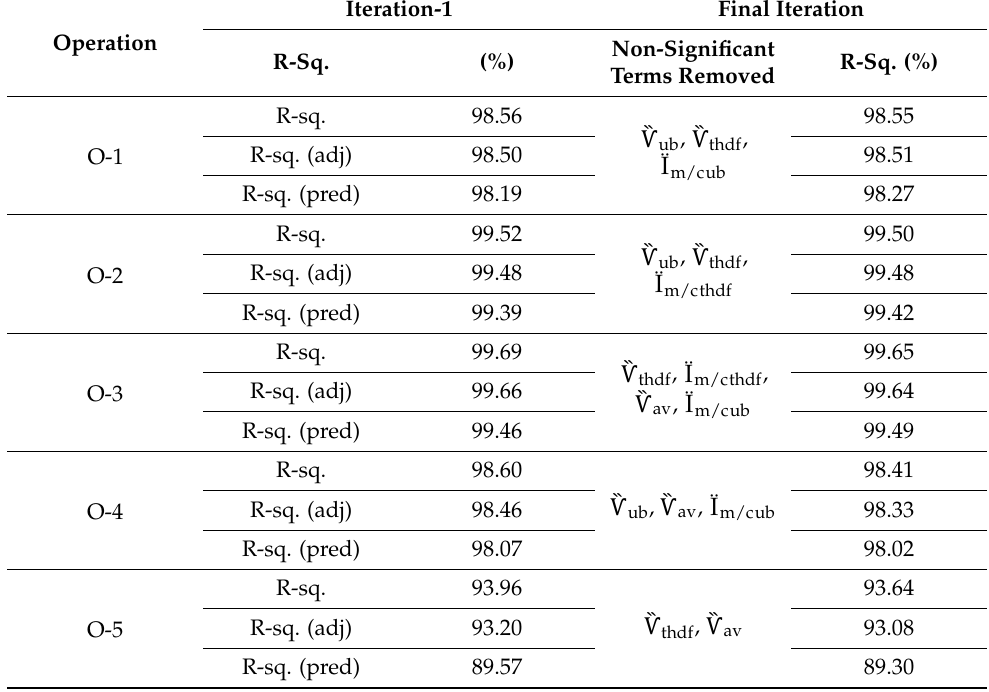
Table 8. Coefficient of determination (R-sq.) for O-1 to